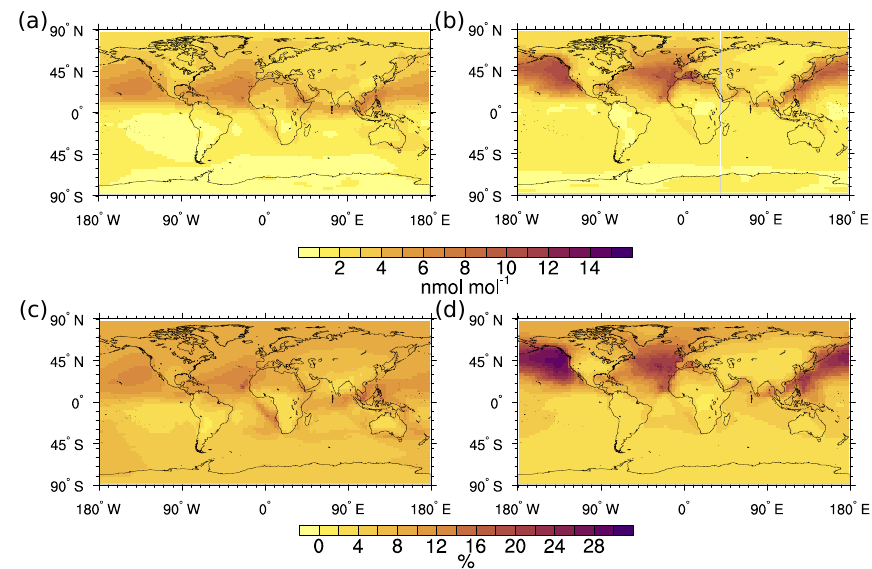
Figure 3. Seasonal average values of the absolute and relative contribution of O shp values (in nmolmol − 1 ) for DJF (a) and JJA (b) . The lower row shows the DJF (c) and JJA (d) values of the contribution (in